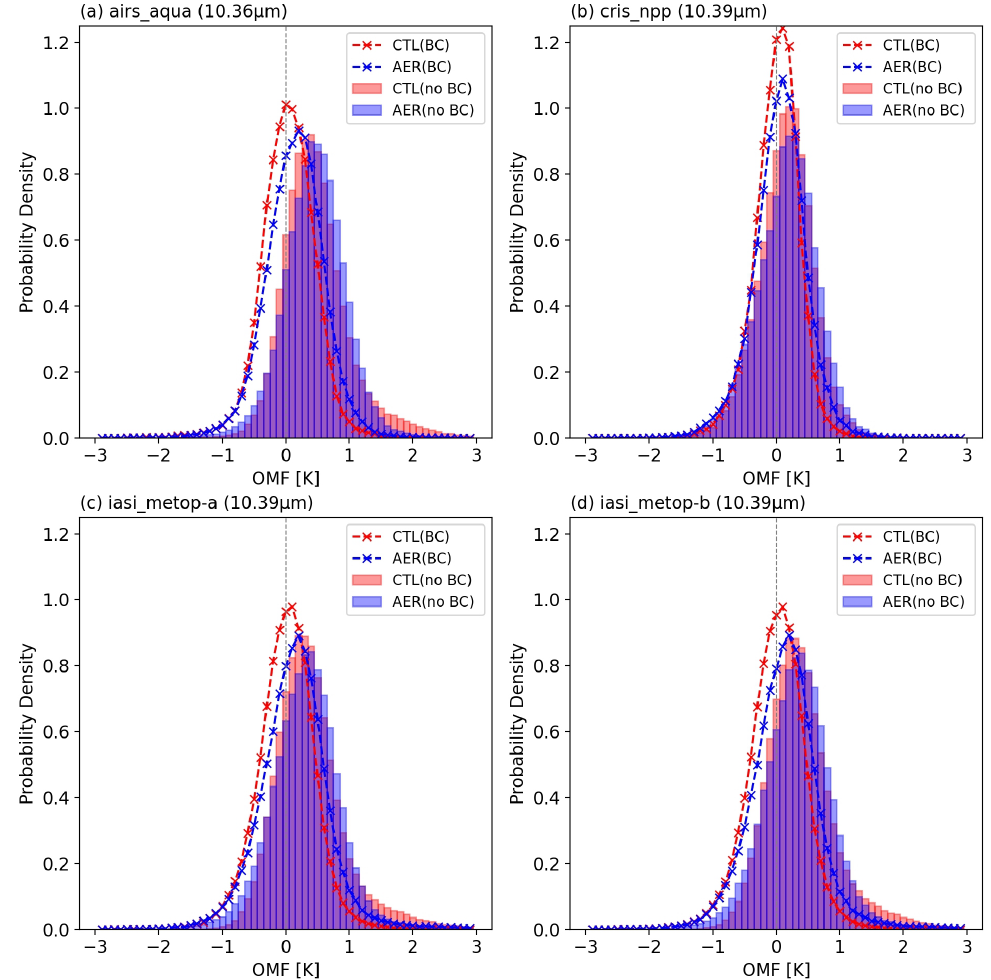
Figure 10. Probability density function of first-guess departures over all assimilated observations (after QC) of CTL (red) and AER (blue) near 10.3 µm on ( a ) AIRS on Aqua ( b ) CRIS on Suomi-NPP ( c ) IASI on MetOp-A and ( d ) IASI on MetOp-B during 1–28 August 2017. Dashed lines stand for the results after BC, whereas histograms stand for the results before